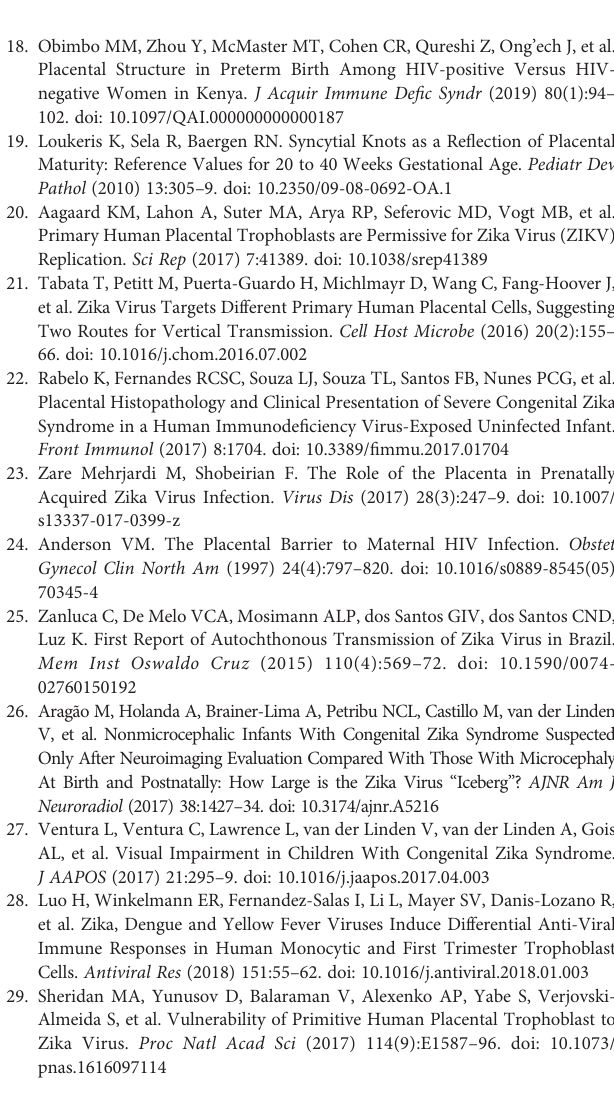
Supplementary Figure 1 | Illustrative fi gure shows the morphometric differences between N-control and ZIKV group and between N-control and HIV group, respectively. However, it also represents similar morphometrics results when the ZIKV group was compared with the HIV group. The N-control group ’ s syncytial membranes are more ef fi cient in exchanges because the vessels are closer to the cytotrophoblast. In ZIKV- and HIV-infected placentas, villus increases in size, moving the vessel away from the trophoblast layer, distancing the syncytiotrophoblast membranes cause intrauterine death, premature, low birth weight babies, and/or other malformations. Created with